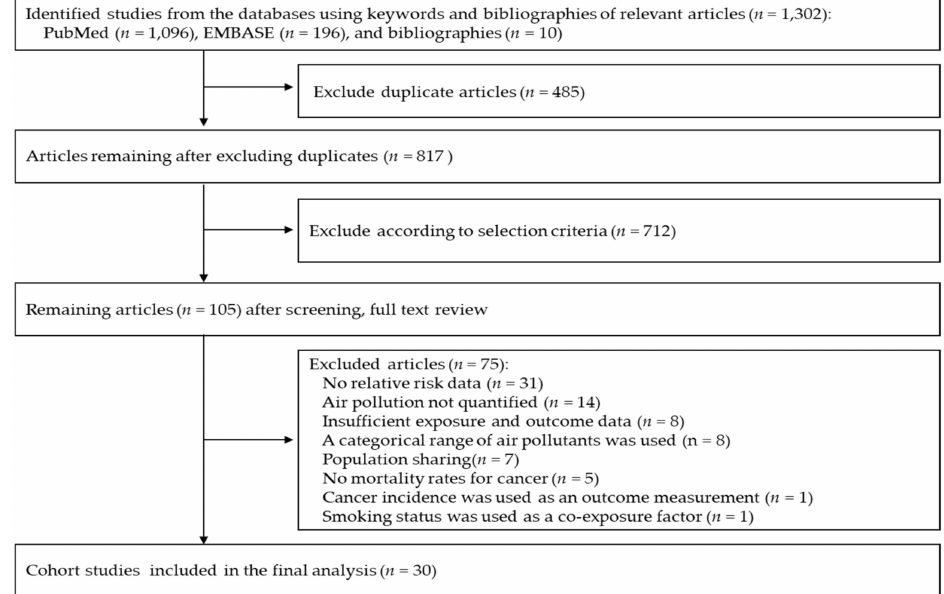
Figure 1. Flow diagram for identification of relevant